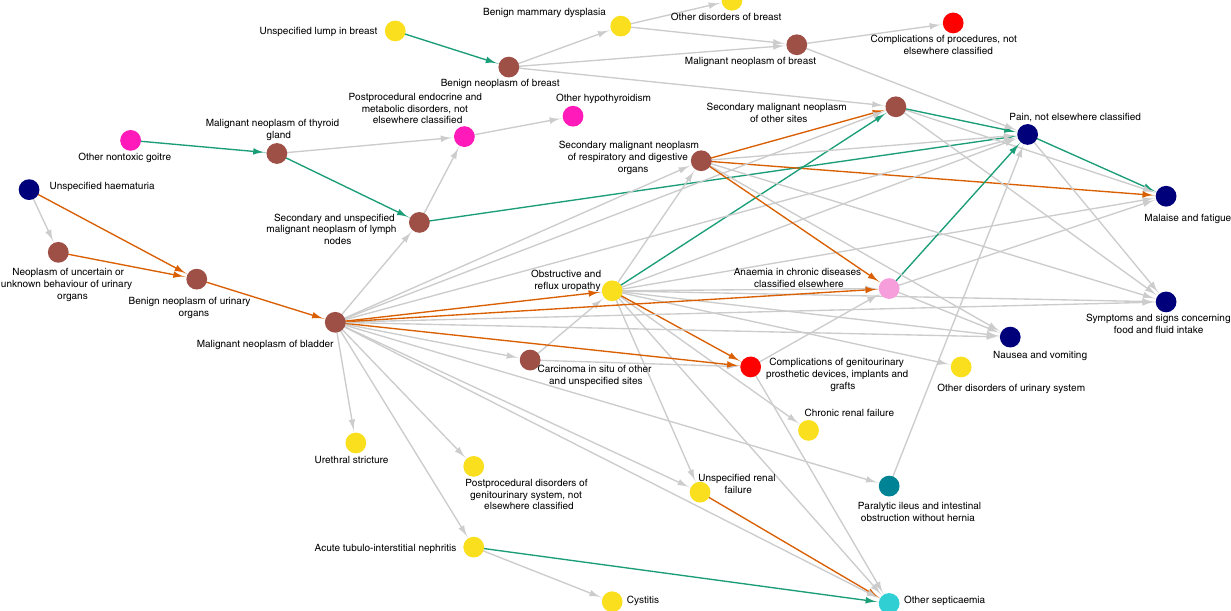
Fig. 6 Diagnosis trajectories related to cancer. A trajectory network combining 62 linear diagnosis trajectories related to cancer (the ten directional pairs with extreme differences in relative risk). The trajectories illustrate disease routes that are related to cancers in the thyroid gland and urinary tract. The progression pattern includes secondary neoplasms, renal complications, and sepsis. Color scale as in Fig.